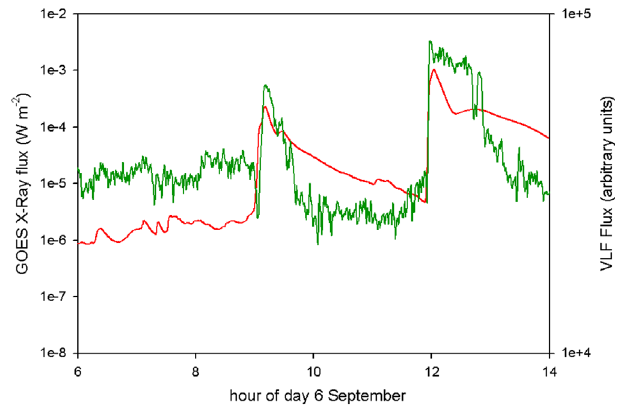
Fig. 3. Superposed plot of the GOES X-ray fl ux (red) and the amplitude of GQD recorded at UAH receiver (green) from 6 to